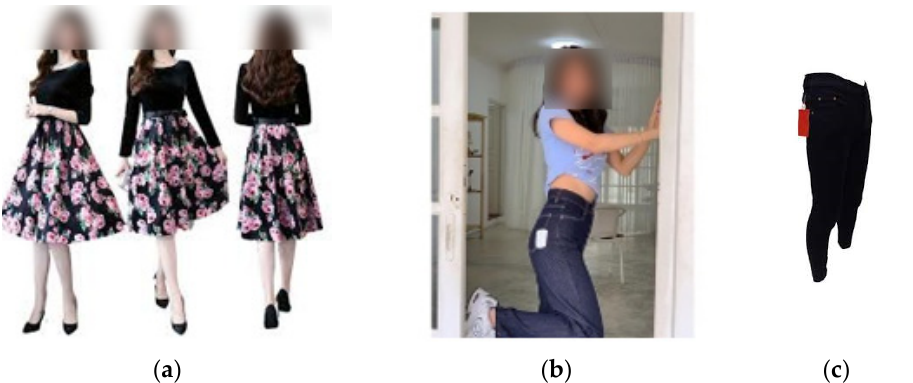
Figure 1. Visualization of the fashion categories. ( a ) different point of view image; ( b ) different photo model position image; ( c ) different perspectives and illumination image.